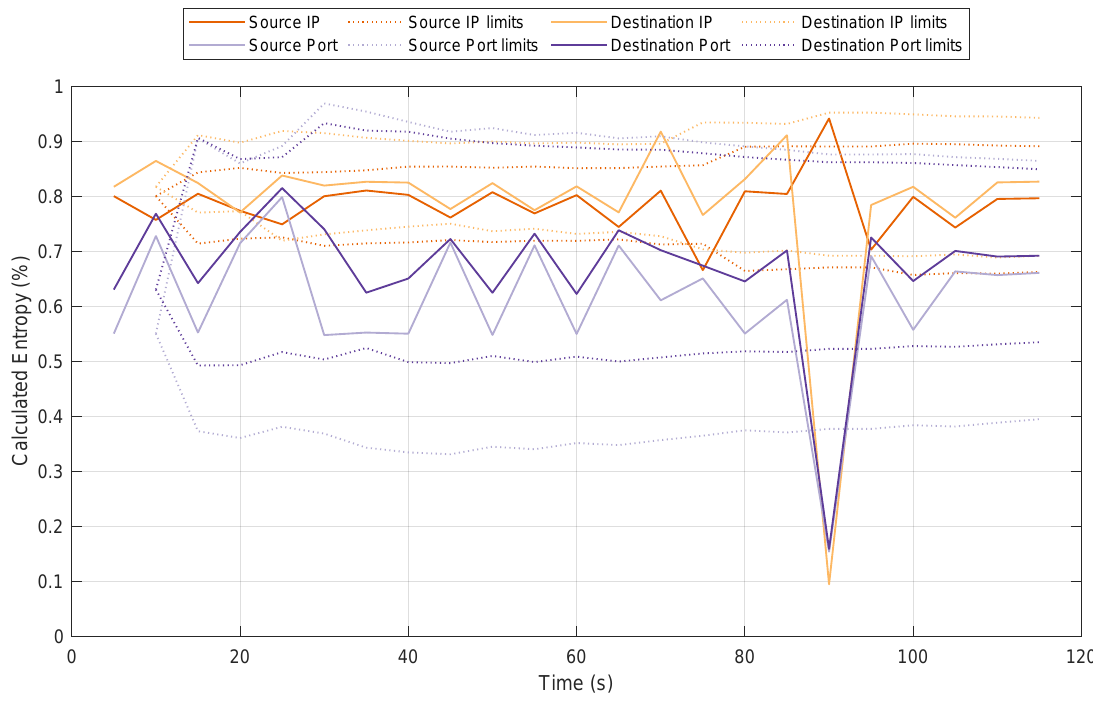
Figure 11. Entropy variation for a DDoS flooding attack in IoT scenario with 15